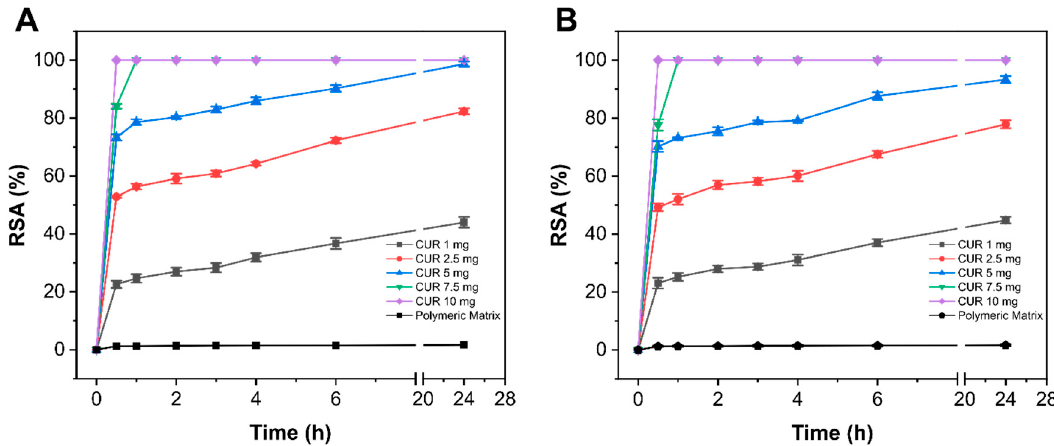
Figure 5. Radical scavenging activity (RSA) of 10, 7.5, 5, 2.5, and 1 mg of Sponge-C ( A ) and Sponge-C-MTR ( B ). The RSA of 10 mg of the Sponge-NLC empty is also reported in the figures and used as a control.